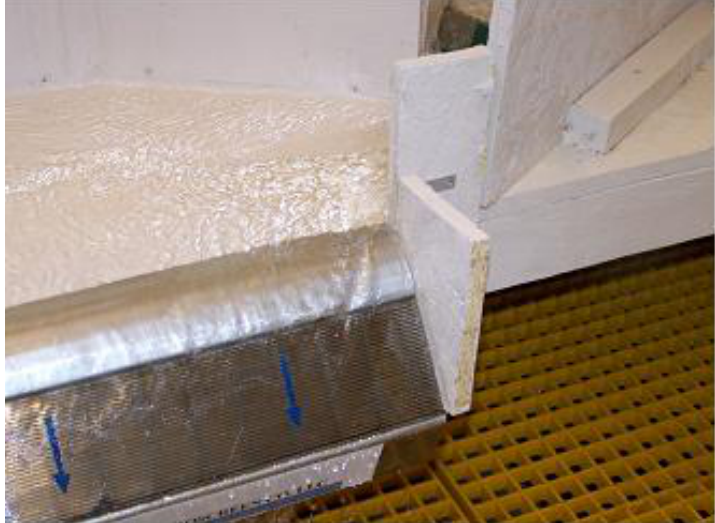
Figure 21. Flow pattern around C-S EF , wall DE and point E